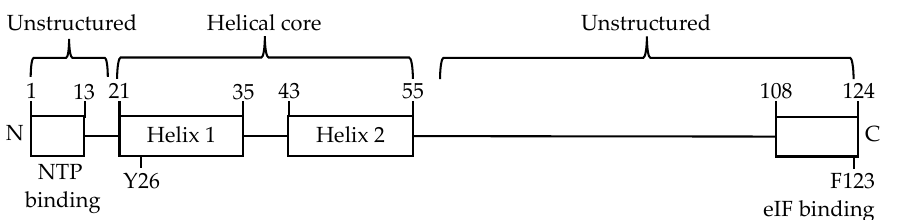
Figure 1. Schematic of MNV VPg. The structural helices and helical core are indicated. Numbers represent the relative positions of amino acids. Amino acid Y26 is essential for nucleotidylylation and F123 is essential for translation. The unstructured N-terminal and C-terminal ends of the protein are indicated. The first 13 amino acids have been shown to be involved in NTP binding by the VPg of HuNV.